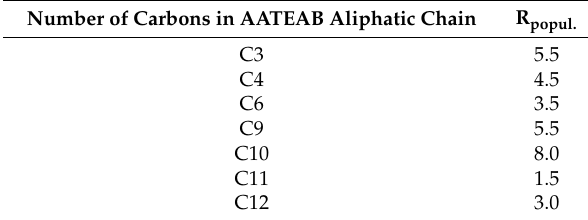
Table 1. Ratio between the group with the maximum number of conformers ( pcg ) and the group containing the conformers with smaller h among the thirty most stable ( sc )